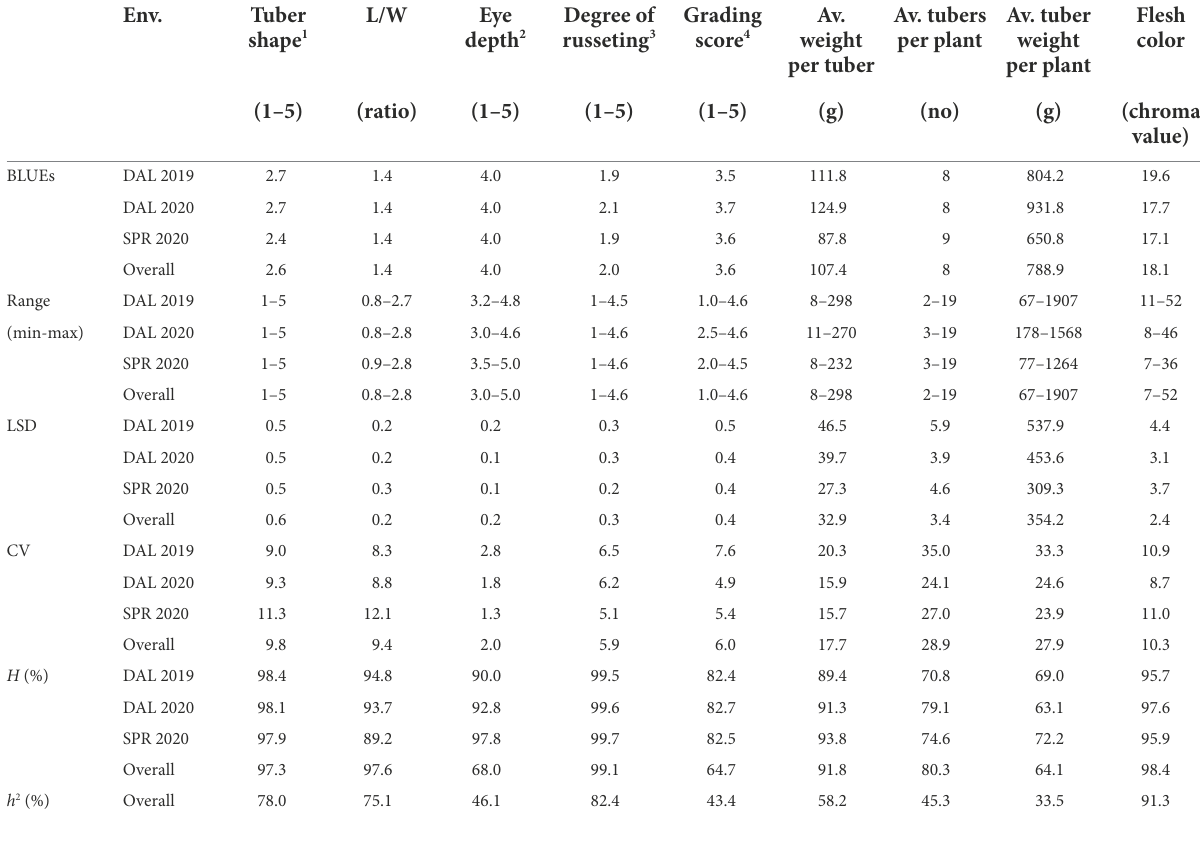
TABLE 1 Summary statistics based on best linear unbiased estimators (BLUEs), broad-sense and narrow-sense heritability for tuber morphological traits of 214 potato clones evaluated in three environments (Env.) in Texas: Dalhart 2019 (DAL 2019), Dalhart 2020 (DAL 2020), and Springlake